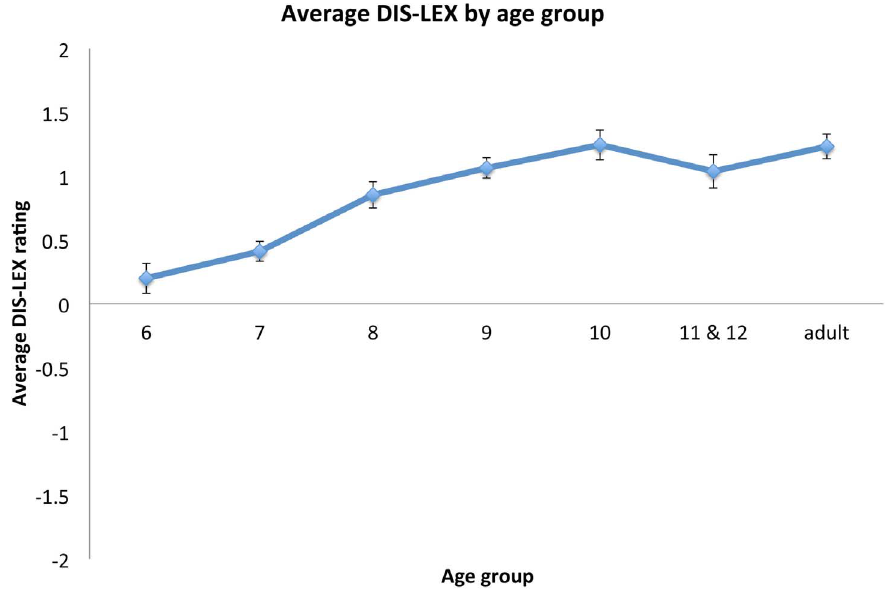
Figure 1. Average DIS-LEX by age group. There was a significant developmental shift even between 6 th and 8 th grades in the difference between the ratings of DIS items and the ratings of LEX items.